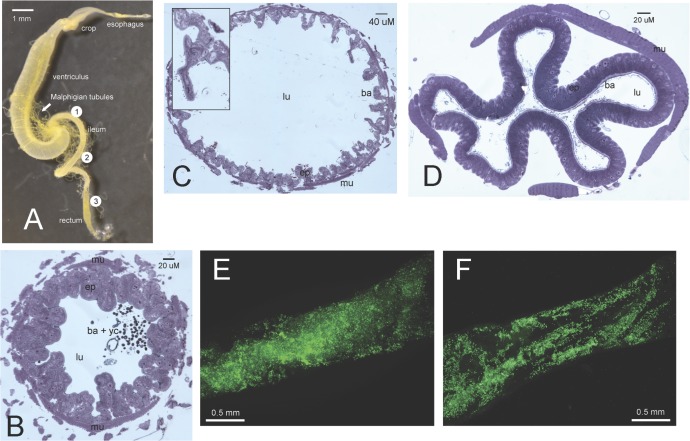
Images of B. impatiens gut (A) from light (B, C and D) and fluorescent microscopy (E and F).(A) shows the whole alimentary canal and general locations where sectioning and imaging were made (multiple individuals were used to create the dissected gut and microscopy images). Section made at (1), (2) and (3) were used to produce images (B), (C) and (D), respectively. Fluorescent images (E) and (F) were produced by visualizing a portion of the ileum located between (1) and (2), and between (2) and (3), respectively. (B) shows both yeast and bacterial cells in the lumen, whereas (C) and (D) show only bacterial cells in the lumen. Villi and longitudinal folds composed of epithelial cells can be observed in (C) and (D), respectively. Insert in (C) shows a villus and bacterial cells (black dots) in greater detail. In (E) and (F), each fluorescing green spot represents one bacterial cell. Abbreviations: ba = bacteria; ep = epithelial cells; lu = lumen; mu = transverse muscle; yc = yeast cell.